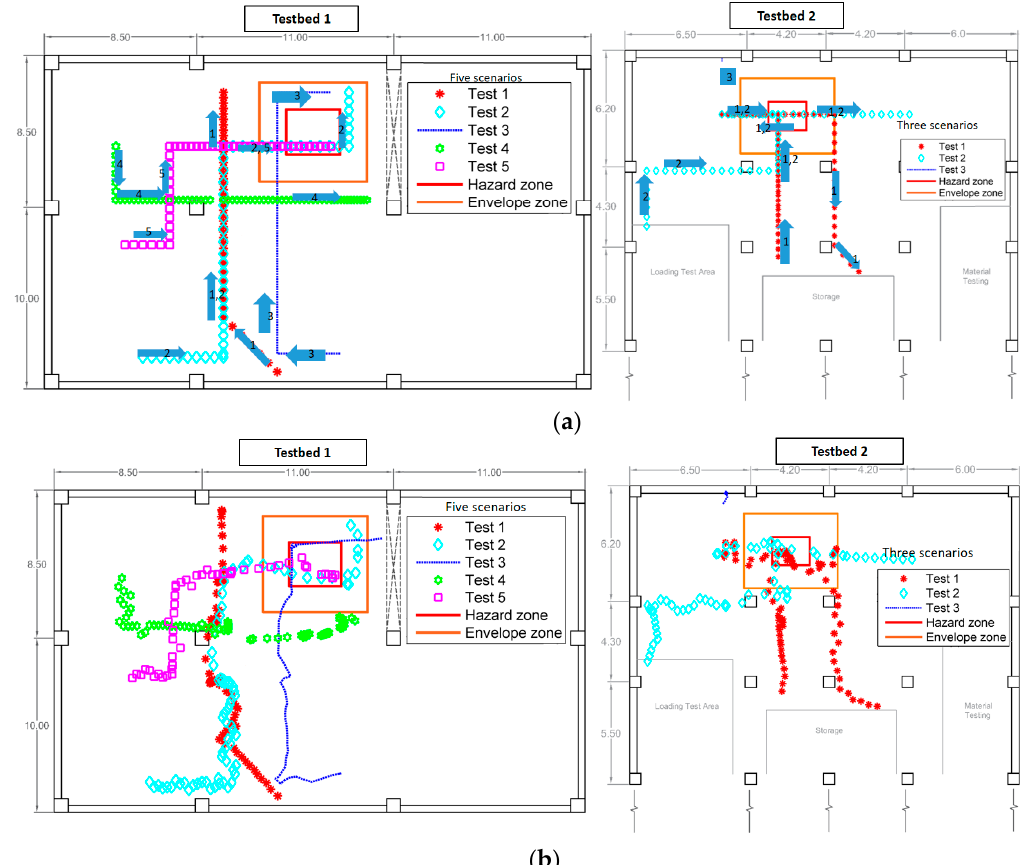
Figure 5. Two testbeds and their hazardous areas.